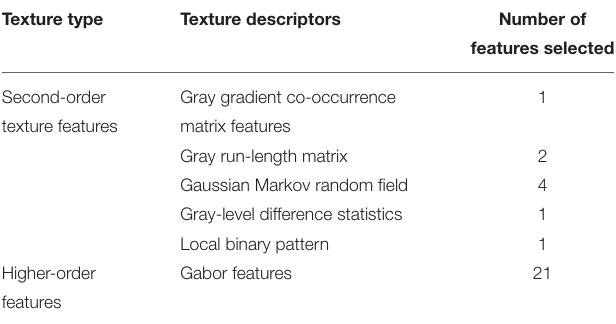
TABLE 3 | Hand crafted-based radiomics features after feature